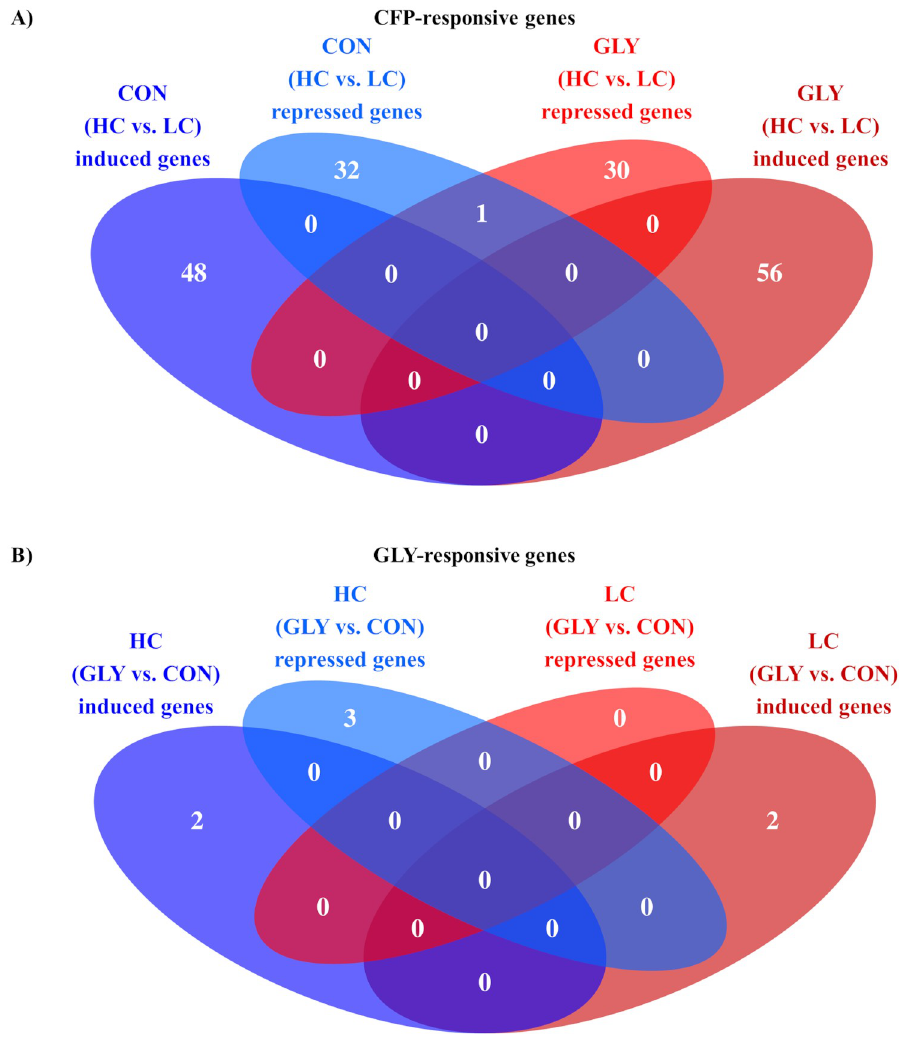
Fig 3. Influence of glyphosate residues and different concentrate feed proportions in diets of dairy cows on liver transcriptome. Cows fed with either GLY-contaminated (GLY groups) or control (CON groups) diets containing high (HC) or low (LC) concentrate feed proportions in their rations. The Venn diagrams show the differentially expressed genes (p < 0.05, p adj < 0.1) after comparing the groups with varying CFP (HC vs. LC, A) or treatment (GLY vs. CON, B). CON = control; GLY = glyphosate; CFP = concentrate feed proportions; HC = high concentrate feed proportion in the diet; LC = low concentrate feed proportion in the diet.